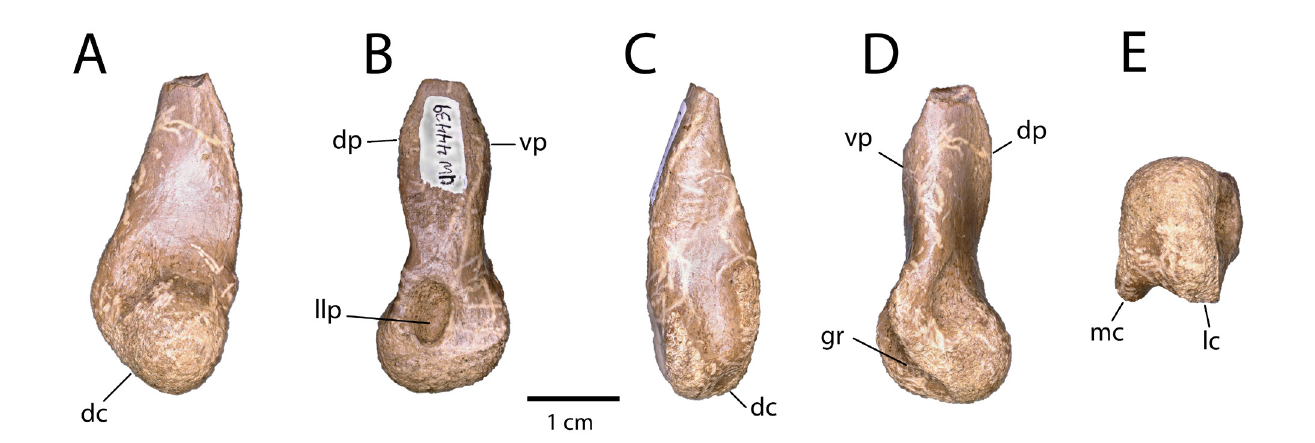
Figure 1. UW 44439, a left metatarsal I of Caenagnathidae indet., in A, dorsal view; B, lateral view; C, ventral view; D, medial view; E, distal view. Abbreviations: dc, distal condyle; dp, dorsal prominence; gr, groove; lc, lateral hemicondyle; llp, lateral ligament pit; mc, medial hemicondyle; vp, ventral prominence. Images are courtesy of Collection of Fossil Vertebrates, Department of Geology and Geophysics of the University of Wyoming.